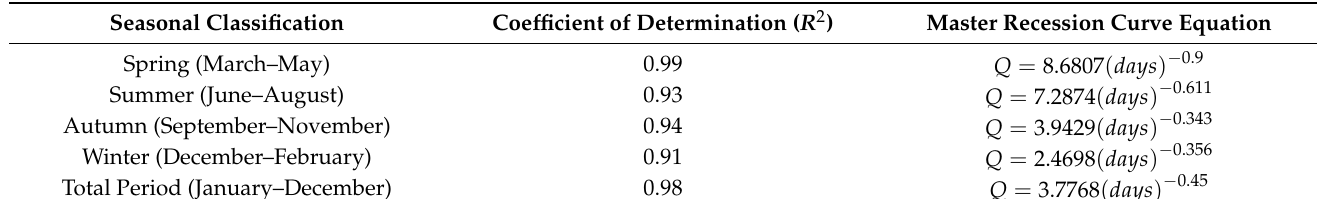
Table 5. Result of calculating the available number of water-intake days curve equation.